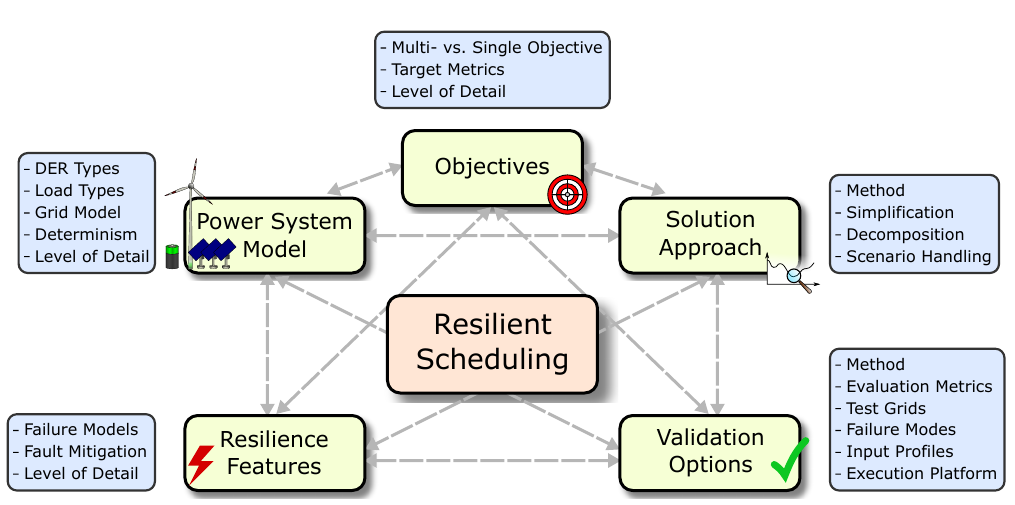
Figure 4. Resilient multi-microgrid scheduling: Design